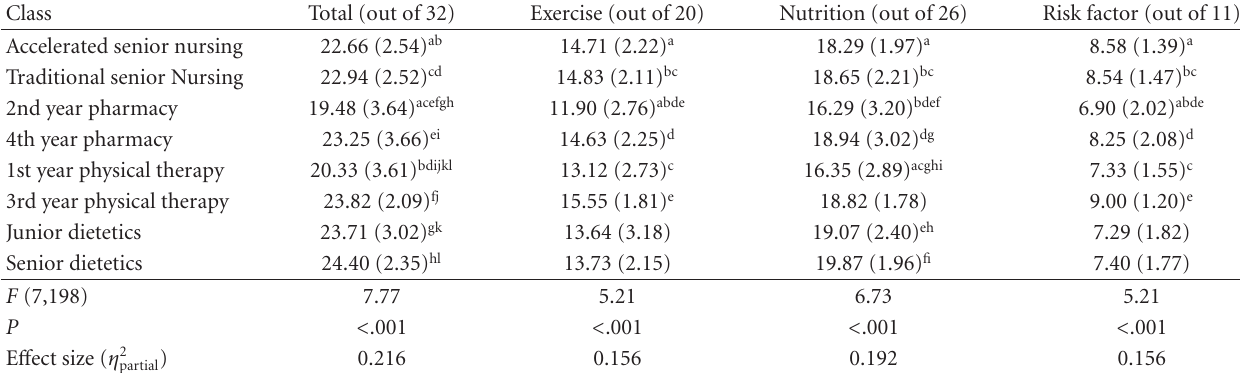
Table 2: Total and subscale scores by class.